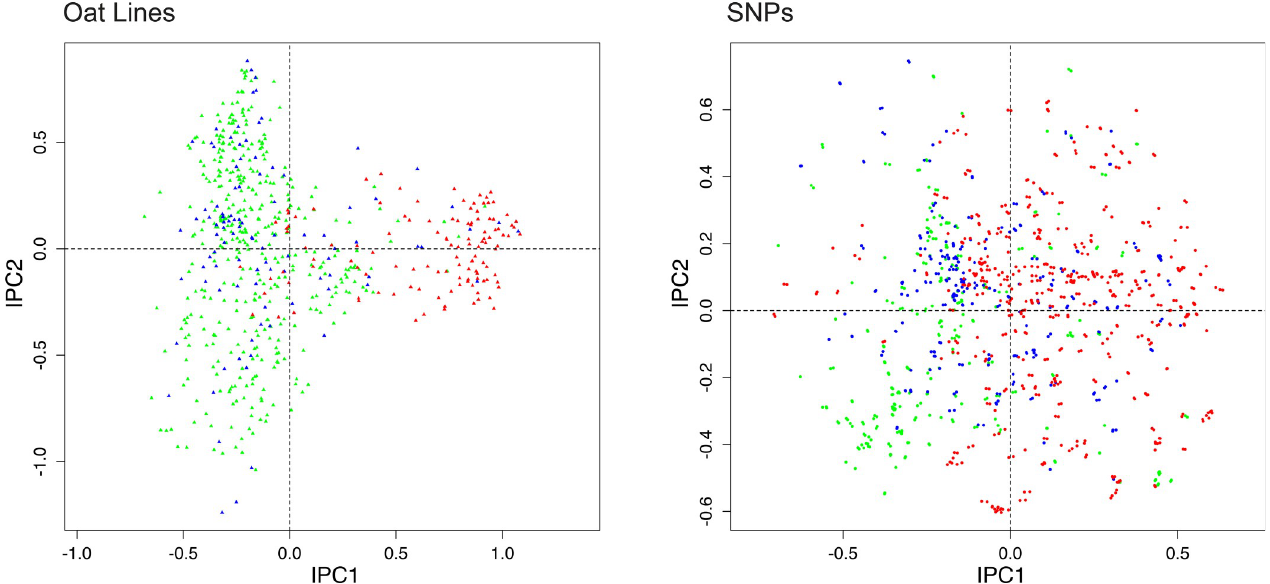
Fig 6. DC-PCA biplot for the oat data, using VCF coding with oat line 189 as the reference genome. The color scheme is the same as in Fig 1, namely spring oats show in green, world diversity oats in blue, and winter oats in red, with corresponding colors for the SNPs. Compared to Fig 1 with SNP coding rare = 1, not only has the pattern for SNPs been totally obliterated, but also the pattern for oat lines has been changed noticeably.